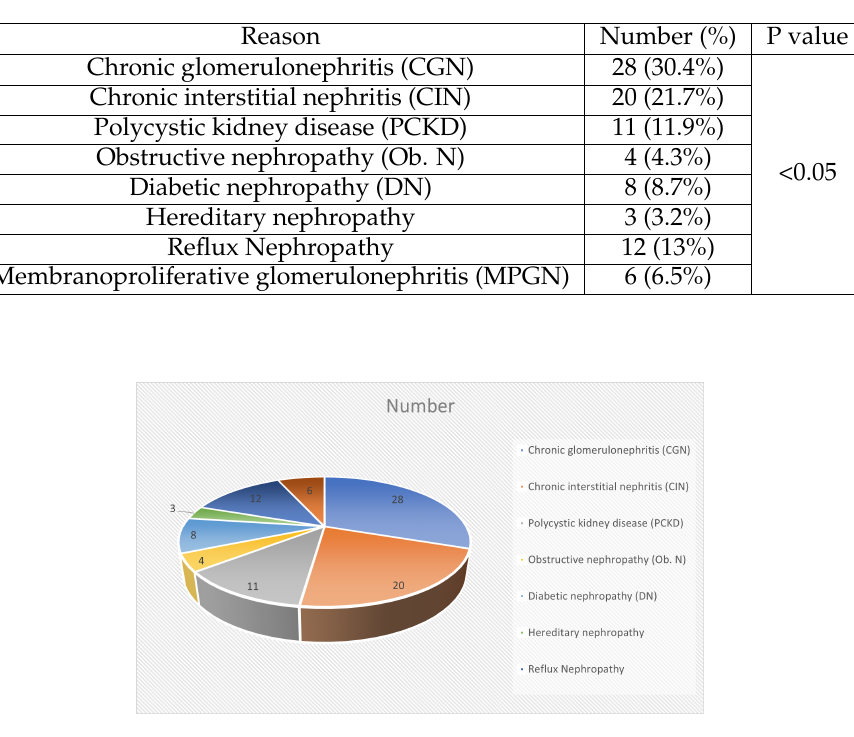
Figure 1. End stage kidney disease